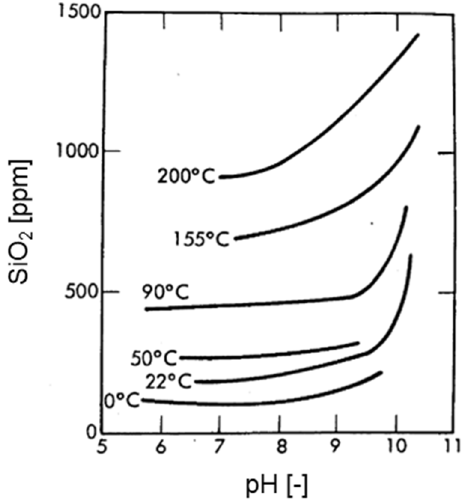
Figure 2. Dependence of SiO 2 solubility on temperature for amorphous silica, reprinted with permission from Ref. [1].